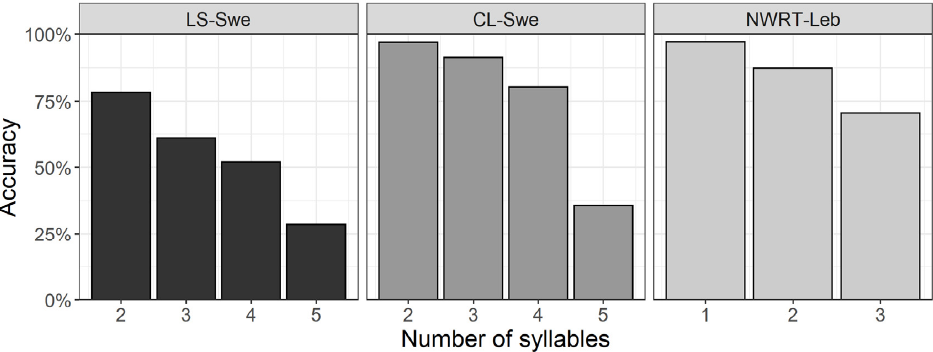
Figure 1. Accuracy (% correct responses), LS-Swe, CL-Swe and NWRT-Leb by number of syllables. As presented in Table 7, accuracy was generally highest for items with fewer syllables and without consonant clusters. In other words, accuracy decreased as a function of increasing number of syllables and the presence of consonant clusters. However, the accuracy patterns for items with vs. without clusters were not the same for the LS-Swe task and the NWRT-Leb. In the NWRT-Leb, accuracy decreased by similar amounts for items with and without clusters as the number of syllables increased. By contrast, for the LS-Swe task, accuracy levels were similar for 2–4-syllable items without clusters, but decreased steeply at five syllables, whilst accuracy levels for the items with clusters decreased for each added syllable. This difference is visualised in Figure 2. Potential interactions between item length and presence of clusters will be explored further in the multivariate mixed-effects regression models. Table 7. Accuracy (% correct responses) by task and number of syllables for all items, items with clusters and items without ( w / o ) clusters.